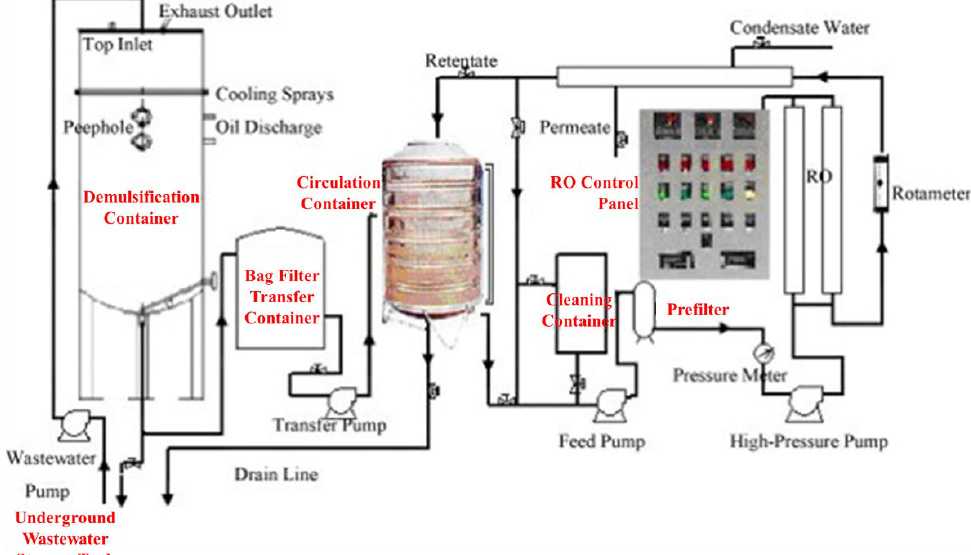
Figure 12. Schematic of the pilot-scale demulsification–RO experimental device [192].